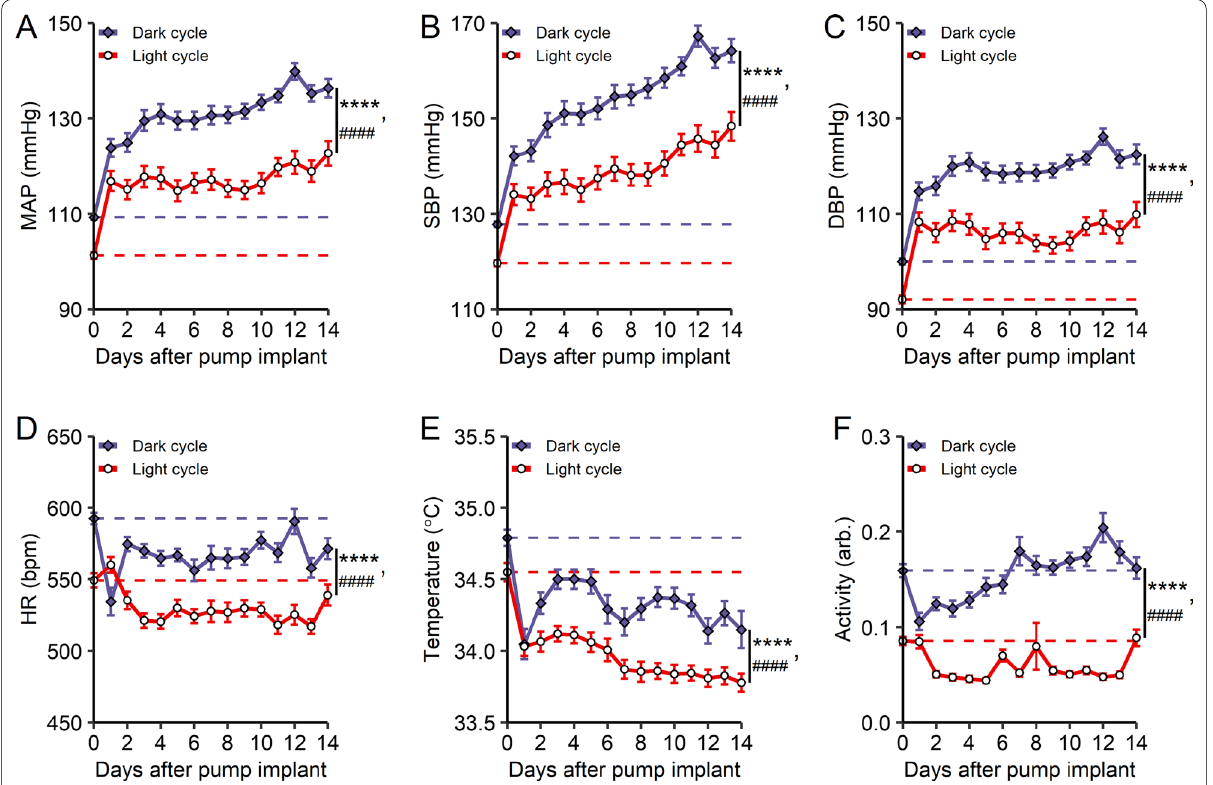
Fig. 2 Angiotensin II‑induced hypertension model. A – F change in MAP, SBP, DBP, heart rate, body temperature, and activity levels during angiotensin II infusion. Dark cycle and light cycle average values were collected prior to and during angiotensin II infusion. Osmotic pumps were implanted on day 0. Data is collected continuously and averaged over the 12 h light and dark cycles separately on each day. Day 0 values represent an average of 3 days prior to implantation of osmotic pumps delivering angiotensin II. Dashed lines represent data in normotensive animals in light and dark cycles. A MAP, B SBP and C DBP significantly increase during angiotensin II infusion. Data are represented as mean SEM, n 41–50, ± = ****p < 0.0001, light cycle vs. dark cycle, #### p < 0.0001, over time, two‑way ANOVA with Sidak’s multiple comparison test. D HR decreases during angiotensin II infusion. Dark cyle HR remains significantly elevated compared to light cycle HR. Data are represented as mean SEM, n 41–50, ± = ****p < 0.0001, light cycle vs. dark cycle, #### p < 0.0001, over time, two‑way ANOVA with Sidak’s multiple comparison test. E body temperature decreases during angiotensin II infusion. Dark cycle body temperature remains significantly elevated compared to light cycle body temperature. Data are represented as mean SEM, n 41–50, ****p < 0.0001, light cycle vs. dark cycle, #### p < 0.0001, over time, two‑way ANOVA with Sidak’s ± = multiple comparison test. F activity levels decrease during angiotensin II infusion, with dark cycle activity levels remaining significantly elevated compared to light cycle activity levels. Data are represented as mean SEM, n 41–50, ****p < 0.0001, light cycle vs. dark cycle, #### p < 0.0001, over ± = time, two‑way ANOVA with Sidak’s multiple comparison